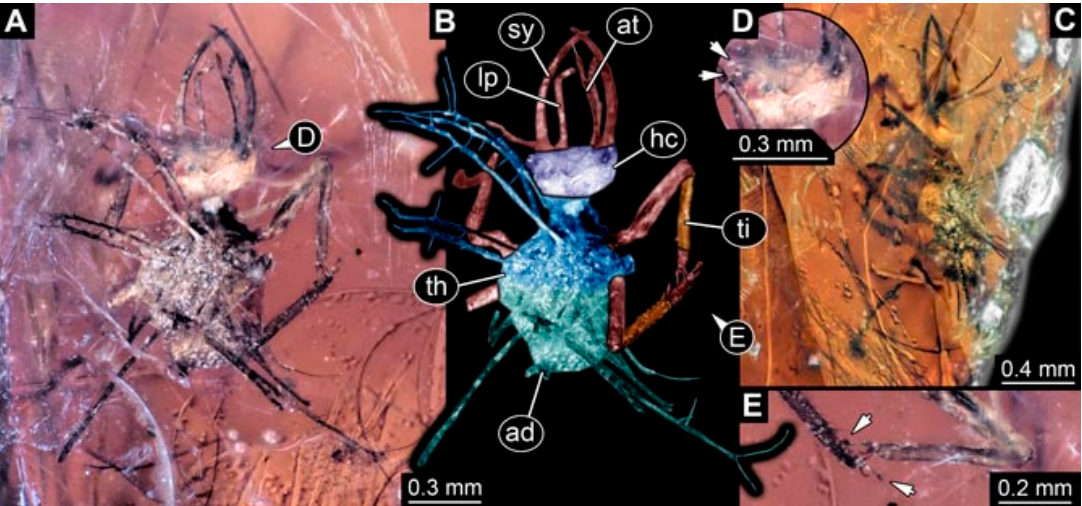
Figure 35. Specimen 4860 (PED 0983); Myanmar amber. ( A ) Dorsal view. ( B ) Dorsal view, colour-marked. ( C ) Ventro-lateral view. ( D ) Close-up of head capsule in dorsal view with stemmata (arrows). ( E ) Close-up of trunk appendages with empodia (arrows). Abbreviations: ad = abdomen; at = antenna; hc = head capsule; lp = labial palp; sy = stylet; th = thorax; ti = tibia.